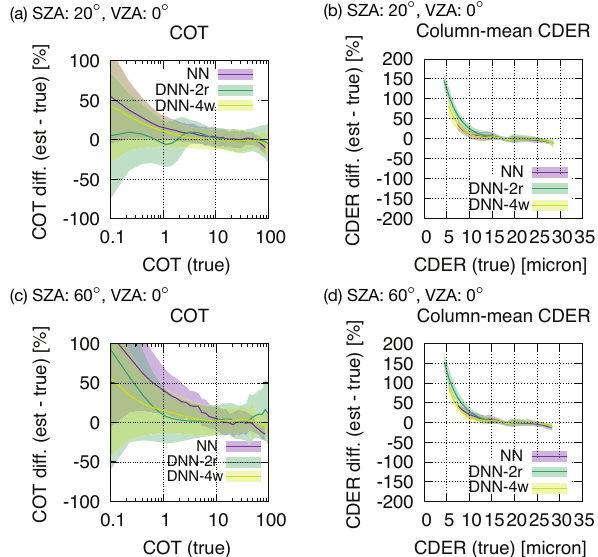
Figure 9. The same as Fig. 7 but for an NN and our DNNs. The solid lines show mean errors, and the shades denote regions of means ± standard